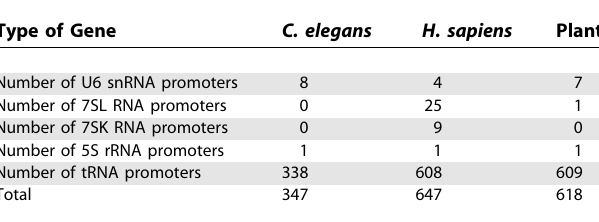
Table 3. The Numbers of Different class-III Promoters in Pol